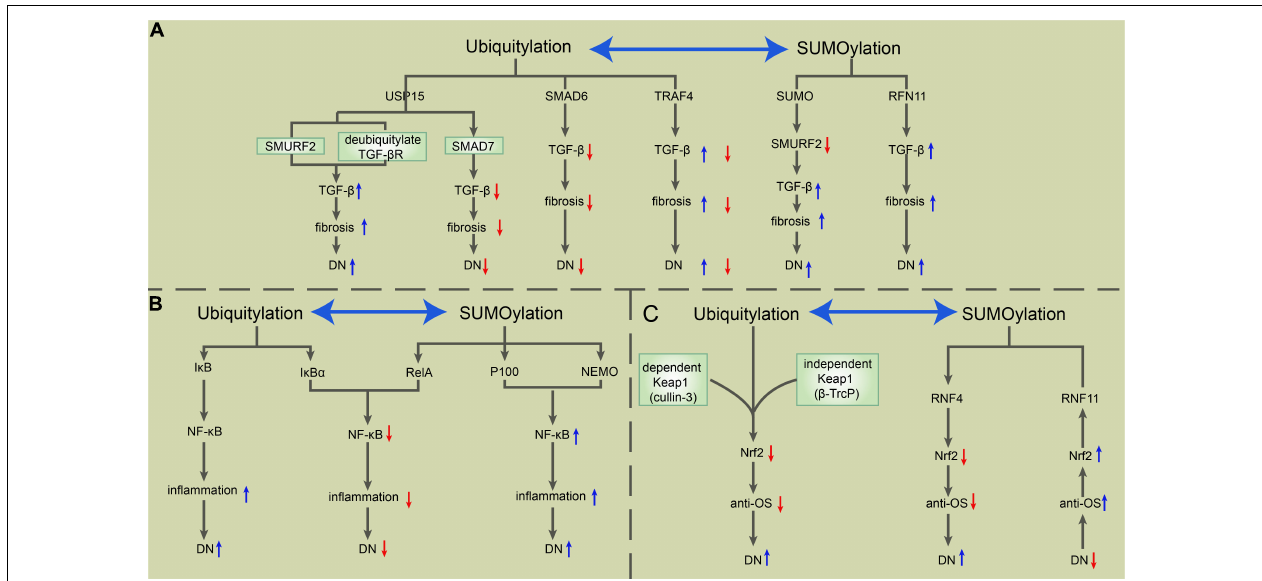
FIGURE 2 | The roles of ubiquitylation and SUMOylation in the modulation of TGF- β , NF- κ B, and Nrf2 in DN. (A) USP15 deubiquitylates TGF- β R and rescues it from SMURF2-mediated degradation, which induces the upregulation of TGF- β signaling and consequent exacerbation of fibrosis and DN. USP15 also binds to SMAD7, forming a complex with SMURF2 that negatively regulates TGF- β . SMAD6 recruits A20 to deubiquitylate TRAF6, consequently inducing the inactivation of TRAF6, which negatively regulates the non-canonical TGF- β pathway. The SUMOylation of SMURF2 upregulates the TGF- β signal. RNF11 is a positive regulator of TGF- β , positively correlated with fibrosis and the severity of DN. (B) Ubiquitylation-mediated phosphorylation of I κ B allows the activation of the NF- κ B complex, which exerts a pro-inflammatory effect during DN. SUMO-1 is directly conjugated to I κ B α at residues K21 and K22, which prevents I κ B α from SUMOylation-mediated I κ B α degradation. Besides, RelA induces NF- κ B repression, while SUMOylation-mediated p100 and NEMO promote NF- κ B activation. (C) Keap1-mediated ubiquitylation of Nrf2 via cullin 3 and the Keap1-independent function of Nrf2 via β -TrCP degrade Nrf2 and weaken the antioxidative stress ability, which in turn exacerbates DN. RNF4 mediates the polyubiquitylation of polySUMOylated Nrf2, leading to its subsequent degradation in PML NBs. However, RNF11 positively regulates nuclear Nrf2 levels during oxidative stress through the RNF11-mediated s-linked ubiquitylation of Nrf2, which results in the stabilization of Nrf2 within PML NBs. NF- κ B, nuclear factor-kappa B; TGF- β , transforming growth factor β ; Nrf2, NF-E2-related factor 2; DN, diabetic nephropathy; USP15, ubiquitin-specific protease 15; TGF- β R, TGF- β receptor; SMURF, SMAD ubiquitylation regulatory factor; TRAF6, TNF receptor-associated factor 6; RNF, really interesting new gene (RING) finger protein 11; NEMO, nuclear factor (NF)- κ B essential modulator; PML NB, promyelocytic leukemia nuclear